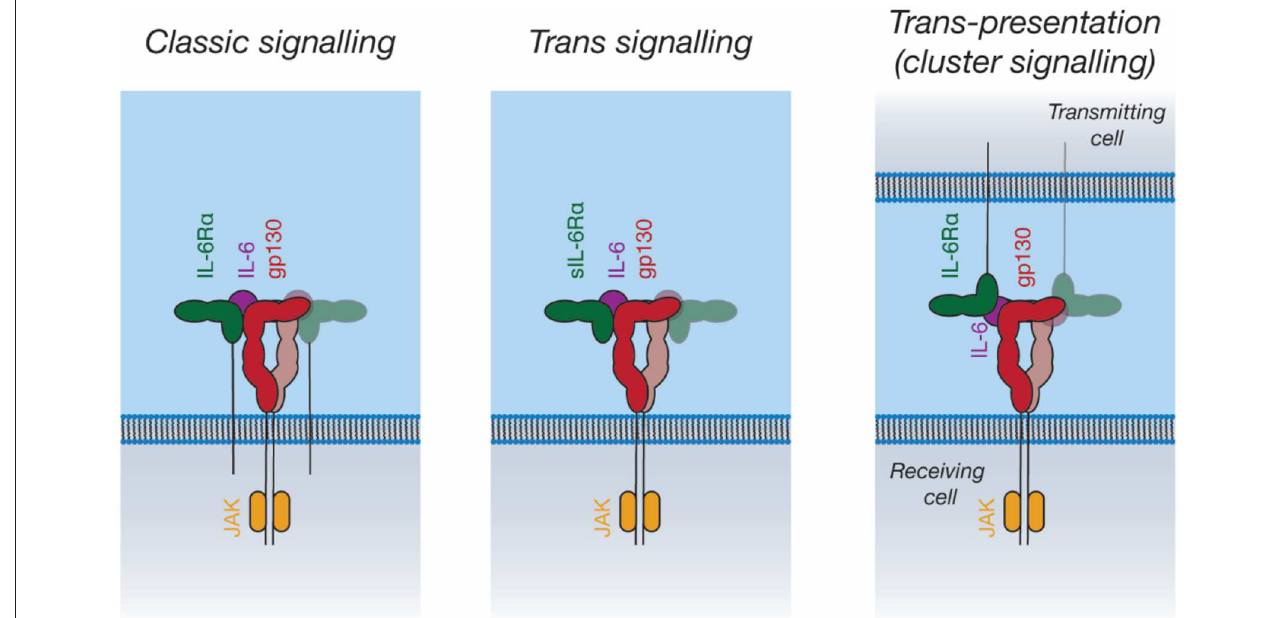
FIGURE 5 | Signal transduction by IL-6. IL-6 can activate intracellular pathways in three ways: “Classic” signaling, in which IL-6 binds to membrane-bound IL-6R α , and subsequently binds to membrane-bound gp130 on the same cell; “trans-signaling”, in which IL-6 binds to soluble IL-6R α , subsequently binding membrane-bound gp130; and “trans-presentation,” in which IL-6 binds membrane-bound IL-6R α on a “transmitting cell” and subsequently engages gp130 on a neighboring (“receiving”) cell, activating intracellular signaling pathways in the receiving